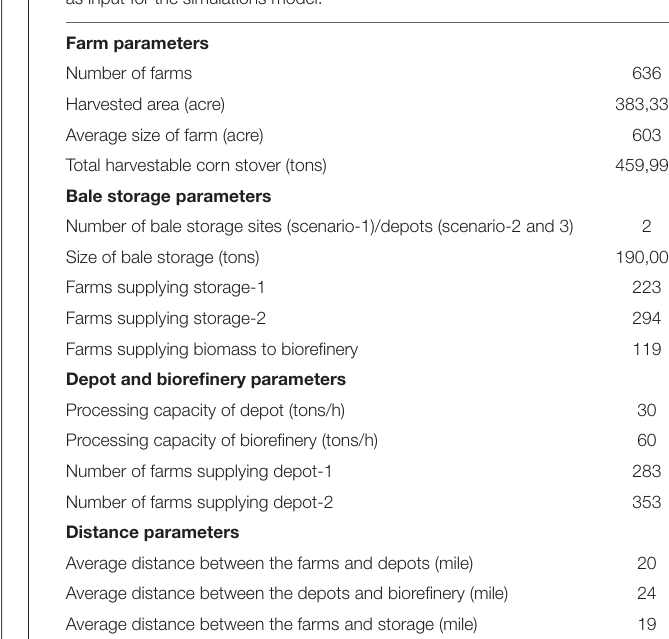
TABLE 2 | Summary of parameters for farms, storage, depot and biorefinery used as input for the simulations model.